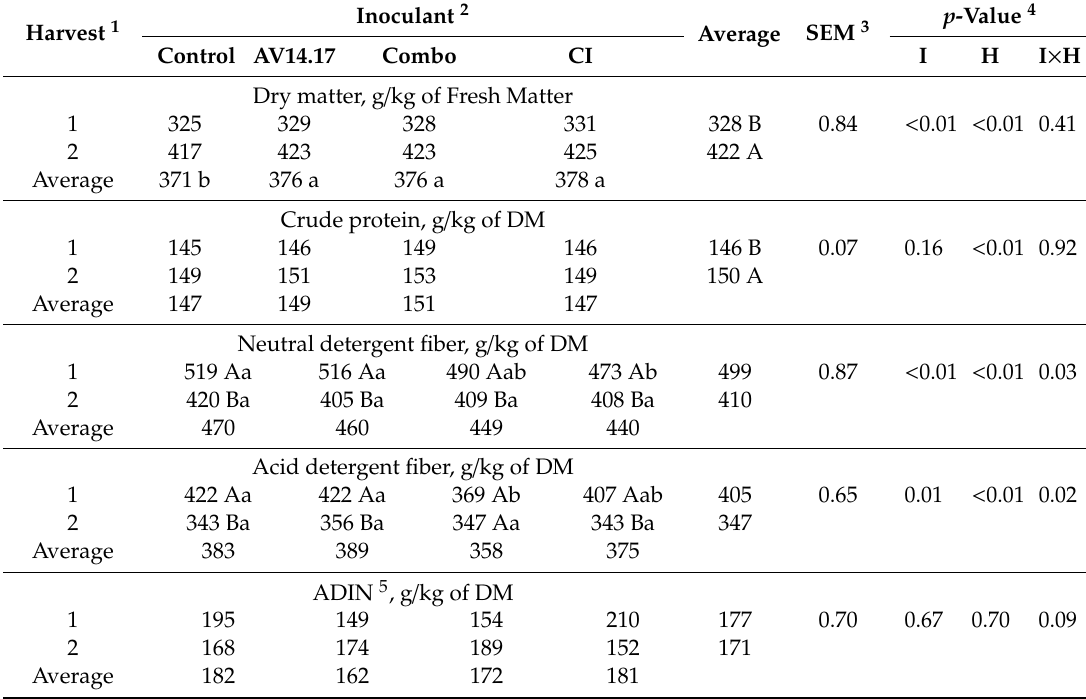
Table 3. Chemical composition of alfalfa silage treated with microbial inoculants at two